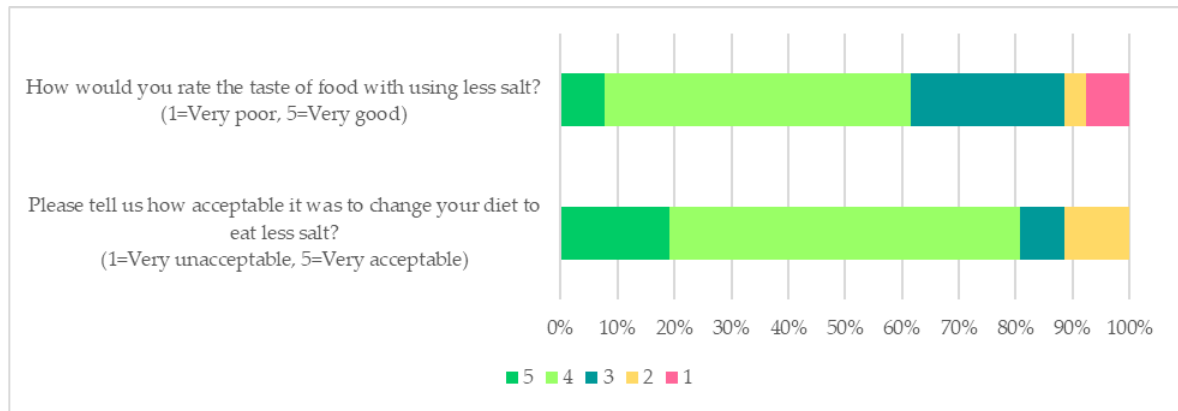
Figure 4. The self-rated acceptability of low salt diet.